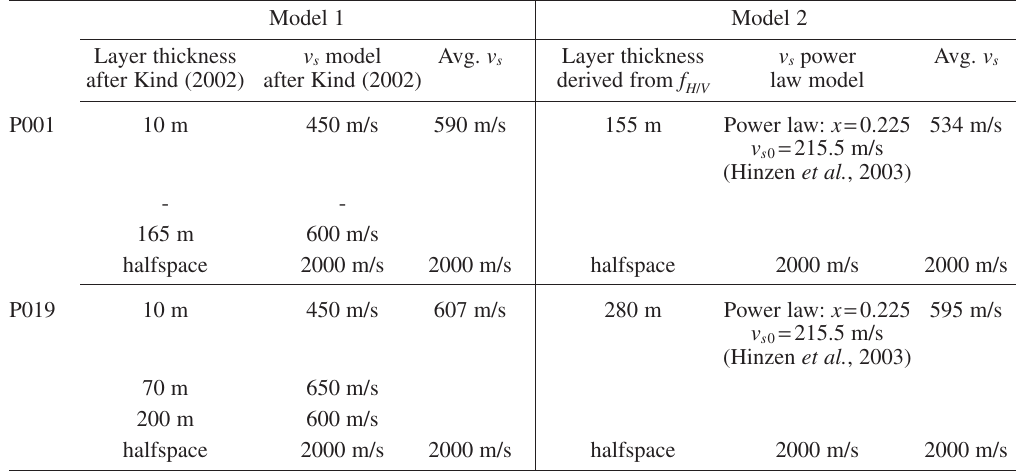
Table II. Depth and velocity models for location A (P001) and A ′ (P019). The models for P019 and the array site are identical.